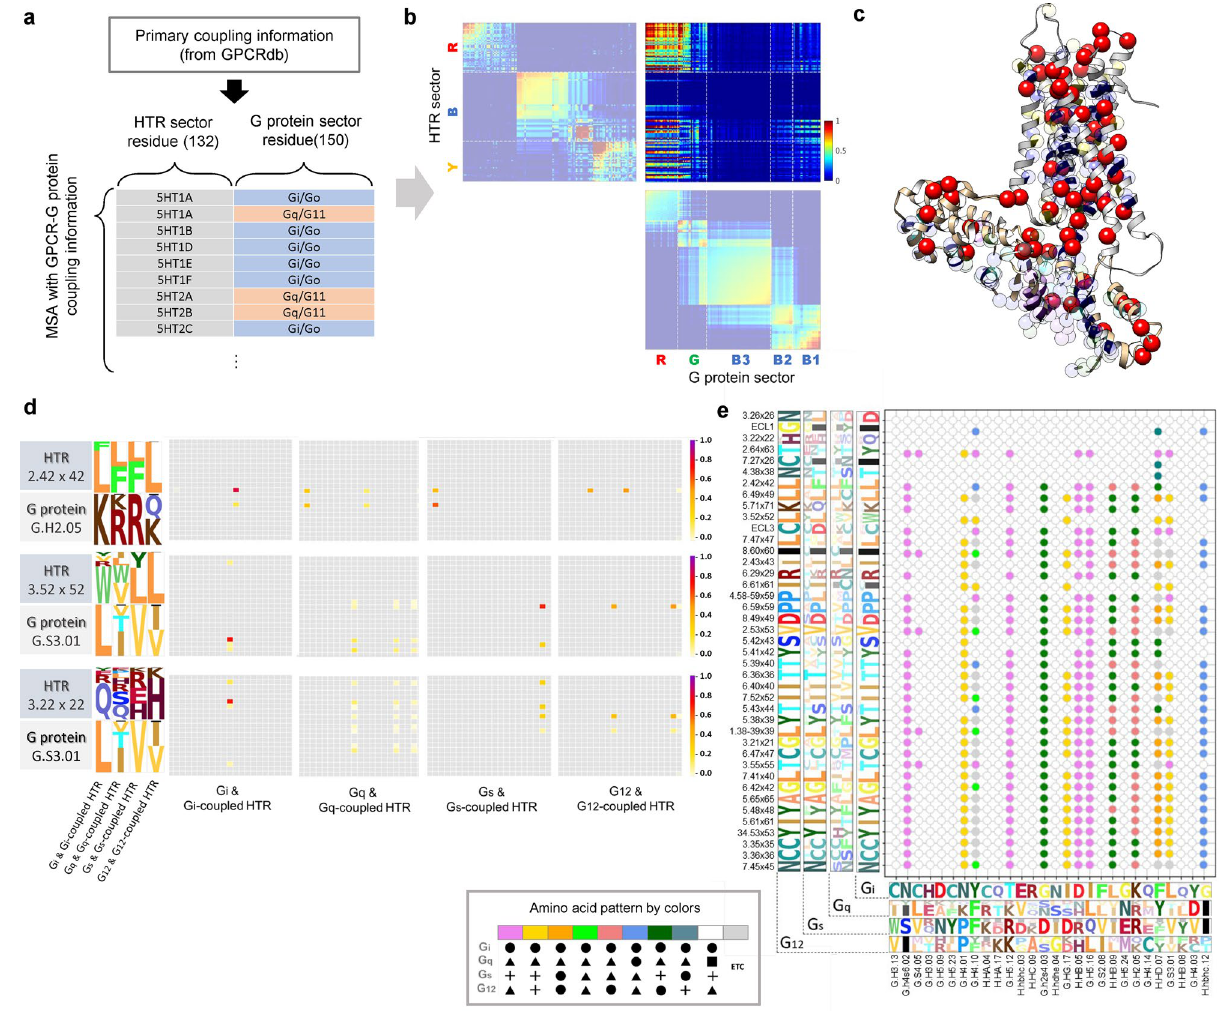
Figure 5. Red sectors are mediator between GPCR and G protein signaling. ( a ) Construction of new multiple sequence alignments for integrated analysis of GPCR-G protein. ( b ) Results of integrated SCA. Blurred matrices are original sector matrix of HTR and G protein. The cross section of each matrix is covariation between HTR sectors and G protein sectors. ( c ) Structure representation of HTR-Red and G-Red which have high coevolution signals. ( d ) Sequence logo and amino acids patterns of HTR-Red and G-Red interaction. In amino acid pattern figure, x, y axis represent the amino acid order of three letter code alphabetically from top to bottom, left to right. (one letter code order: ARNDCQEGHILKMFPSTWYV-, -represents gap). ( e ) Amino acid pattern analysis between HTR-Red and G-Red residues. Patterns of each color are explained in legend. Same shape in each column represents similar distribution of amino acids’